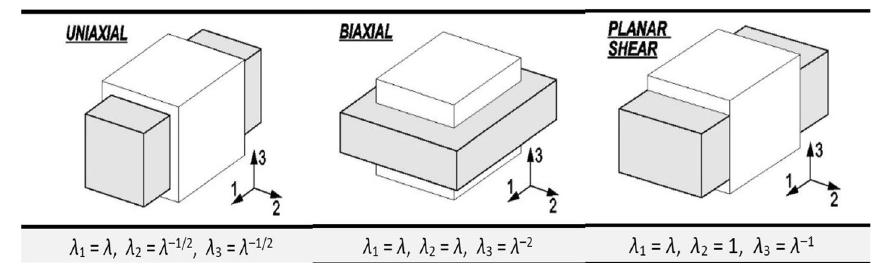
Fig. 4 Uniaxial, biaxial, and planar shear deformation modes and relationships between the